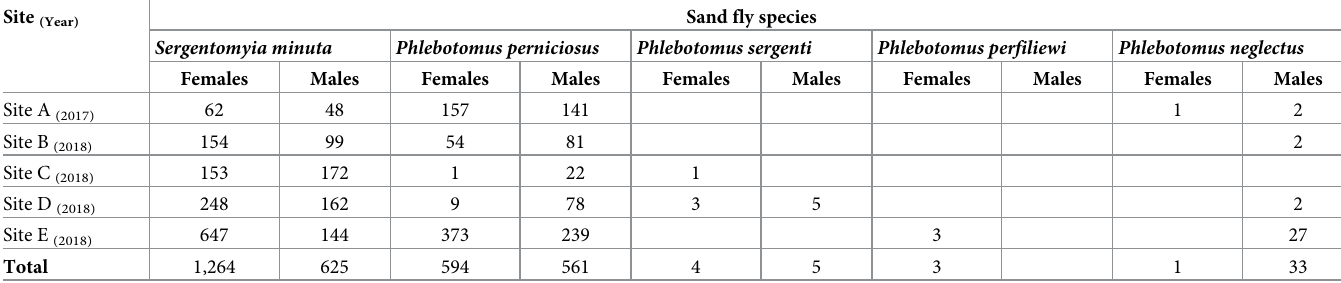
Table 1. Total sand flies collected during the two entomological